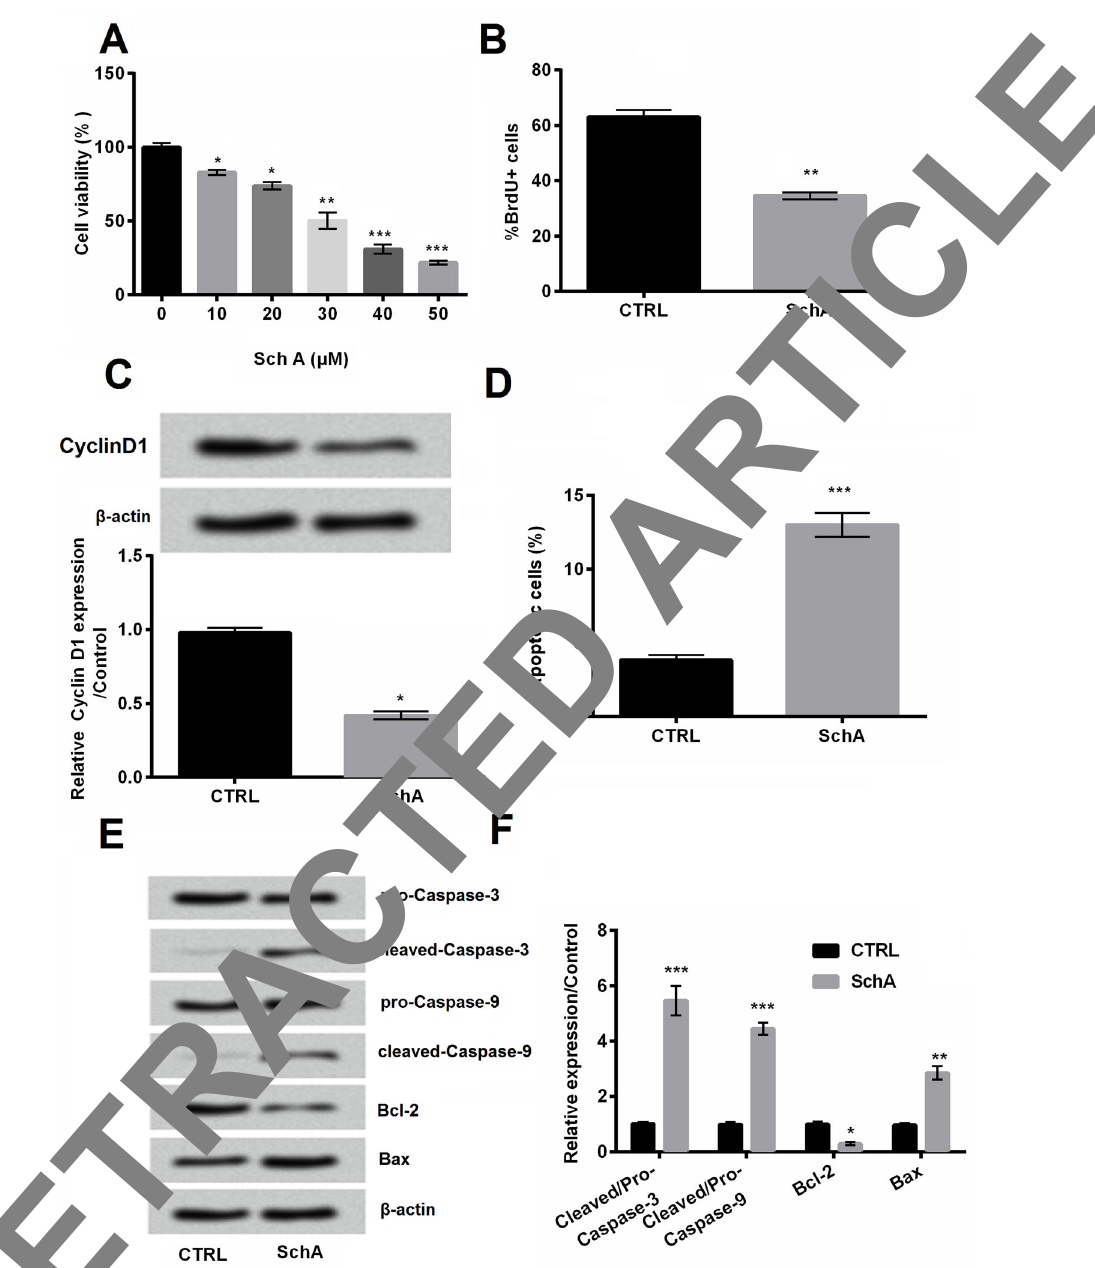
Figure 2. A , Cell viability was detected under different schizandrin A (SchA) concentrations by Cell Counting Kit-8 assay. Cell proliferation ( B ) and ( C ) expression and level of cyclin D1 were analyzed via BrdU, western blot, and quantitatively, respectively. D , Cell apoptosis was analyzed by fl ow cytometry. Cell apoptosis-related proteins were detected by western blot ( E ) and quantitatively ( F ). b -actin was used as control. Data are reported as means ± SD (n=3). *P o 0.05, **P o 0.01, and ***P o 0.001 compared to control (ANOVA and Student ’ s t